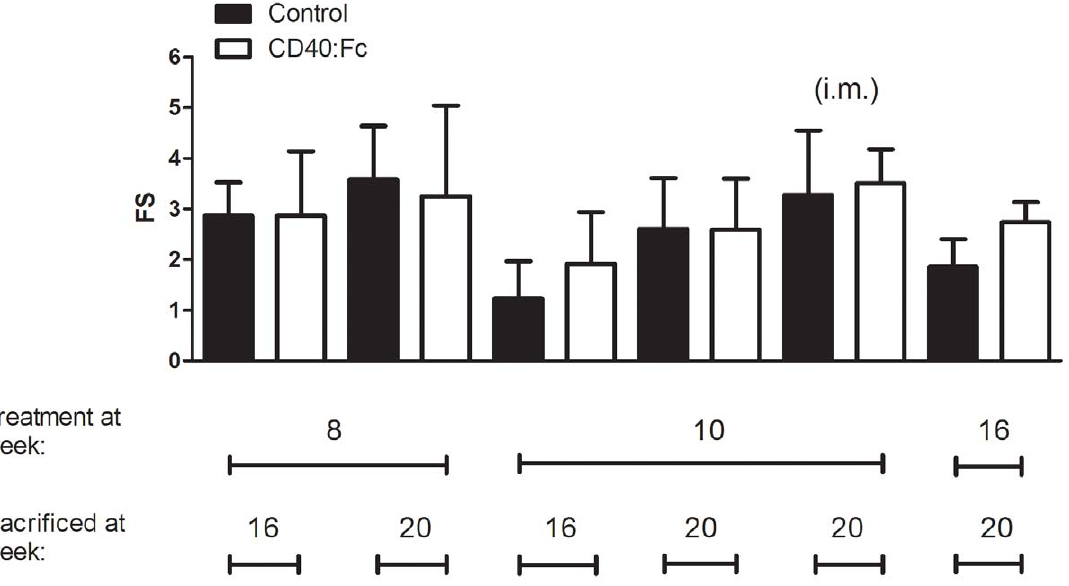
Figure 3. Focus score (FS) of salivary glands (SG) of non-obese diabetic (NOD) mice treated with CD40:Fc at different ages. FS was determined for each group of CD40:Fc treated mice and compared with control mice (n=8–10 mice per group). Shown is the average FS per group.